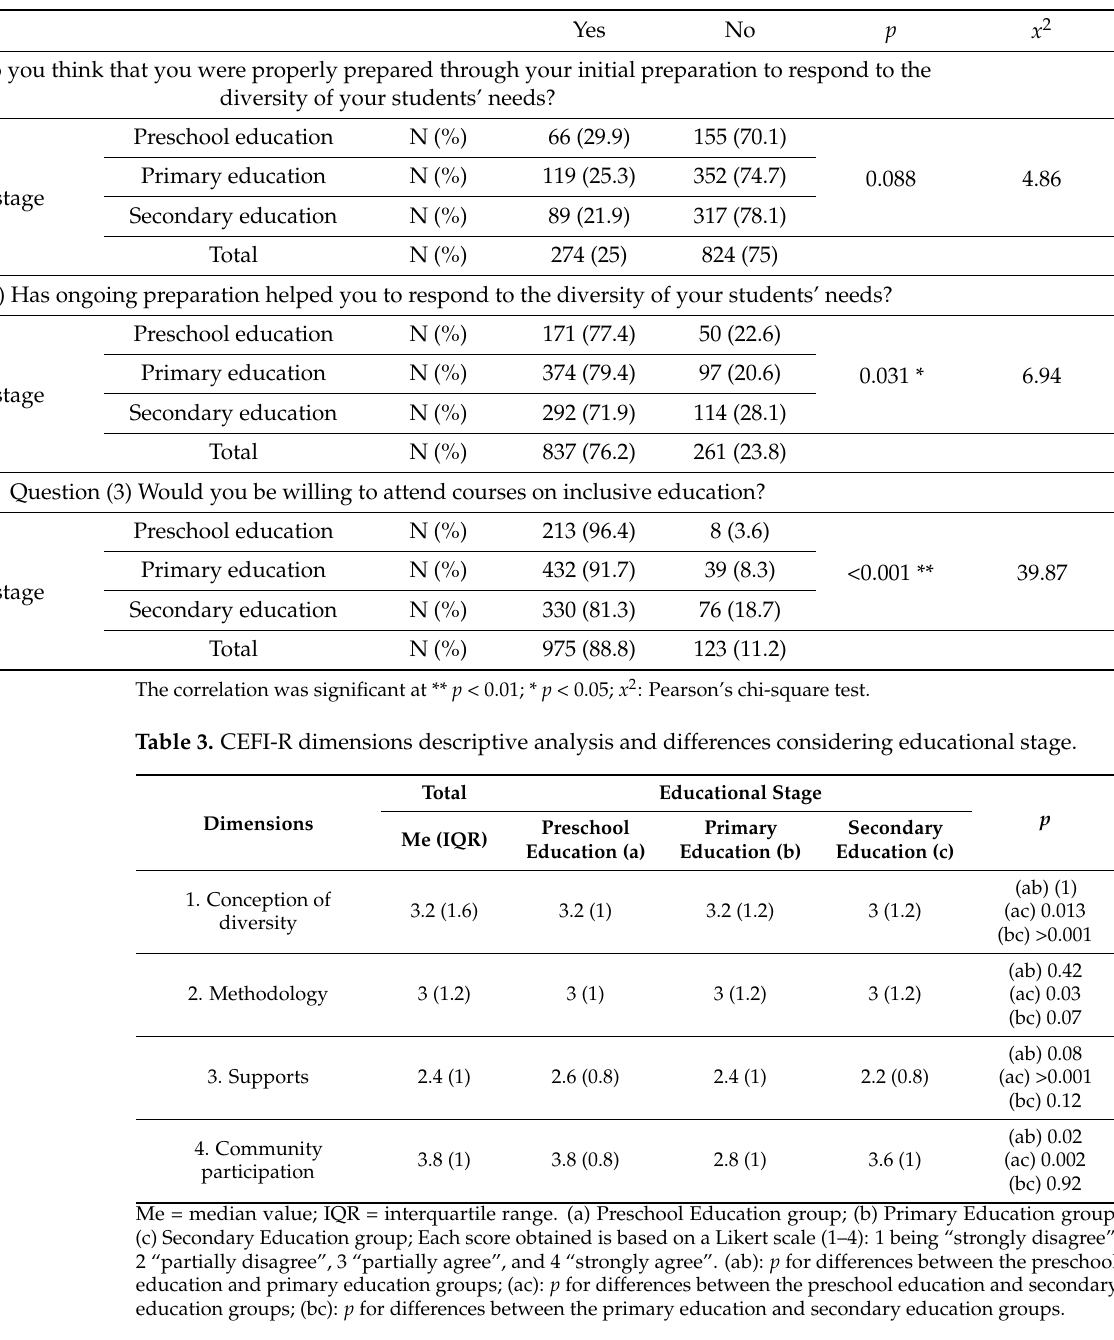
Table 2. Dichotomous questions responses distribution according to teachers’ educational stage.